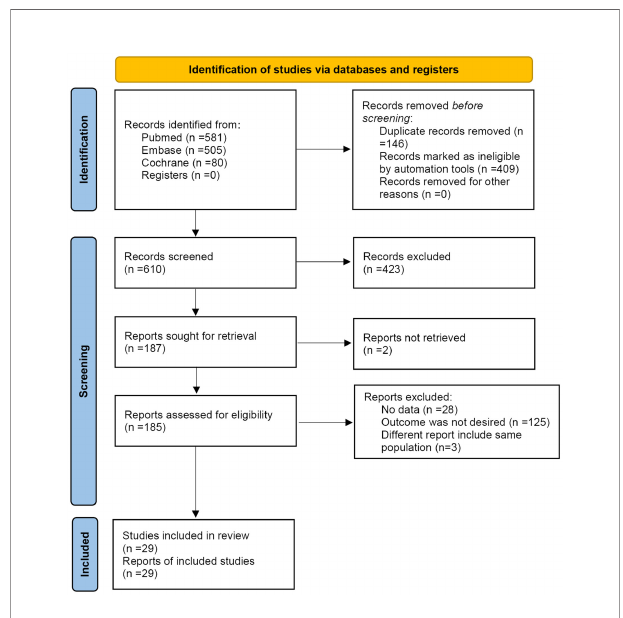
FIGURE 1 | Flowchart of the search